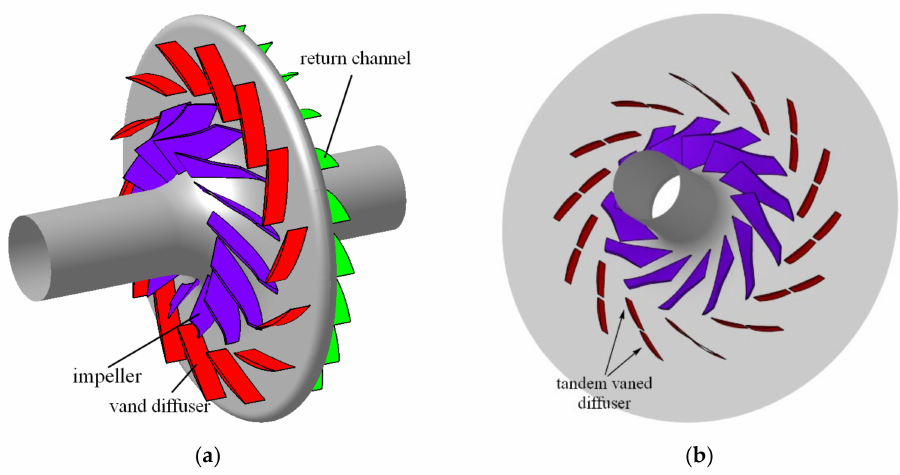
Figure 1. Structural diagram of centrifugal compressor. ( a ) Original model with vane diffuser and ( b ) Model with tandem vane